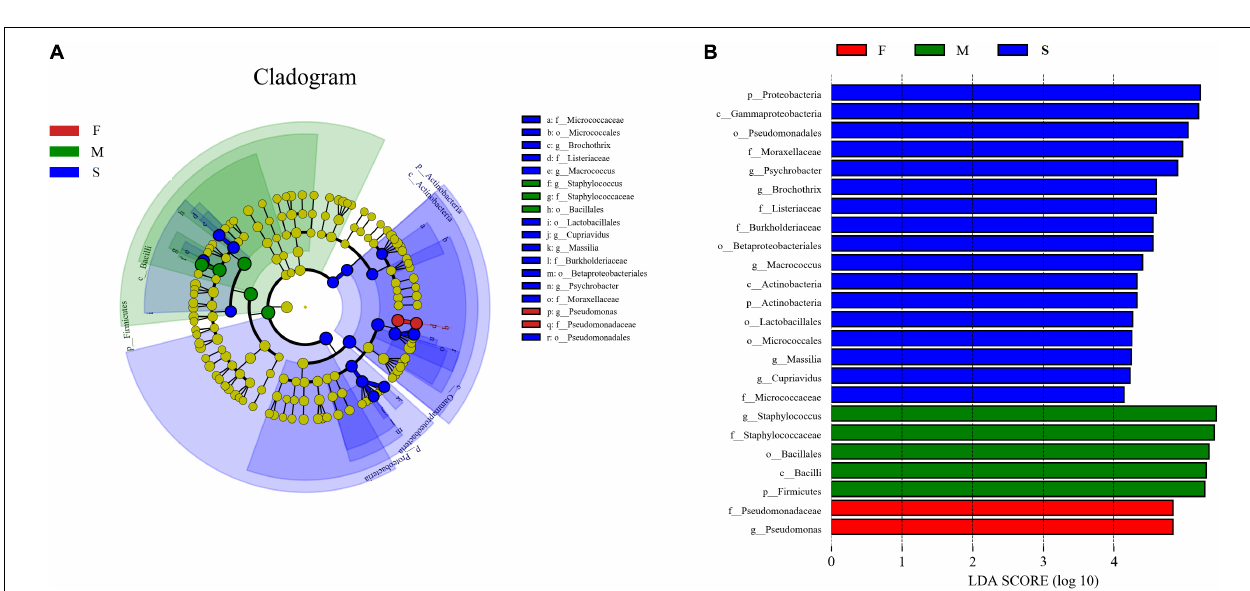
FIGURE 2 | The beta diversity results of NMDS indicating the data distribution of bacon samples (A) ; the unweighted pair-group analysis (UPGMA) based on UniFrac distance for bacterial communities of bacon samples (B) .